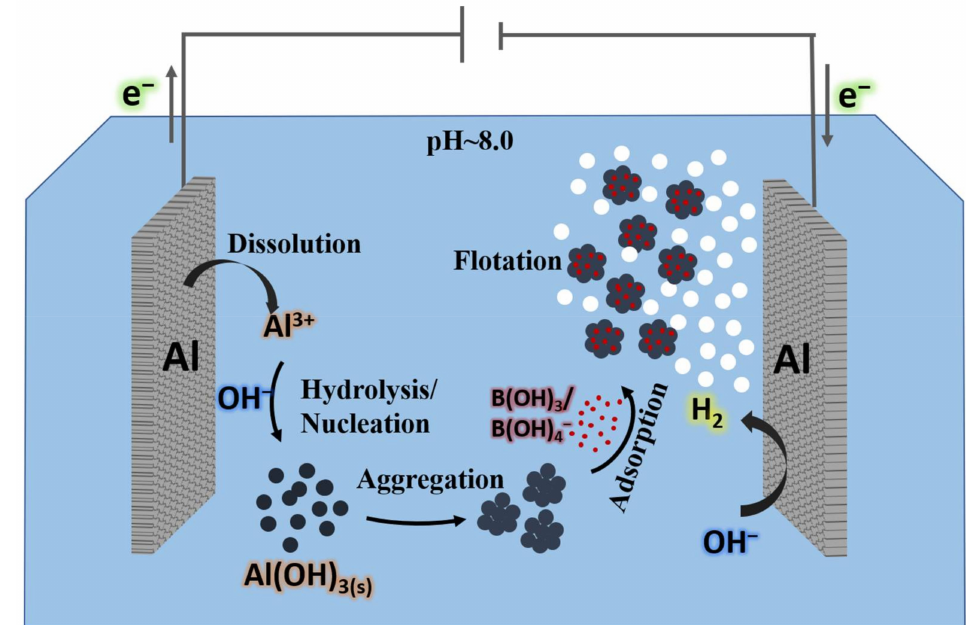
Figure 6. Diagram of the electrocoagulation of boron by Al